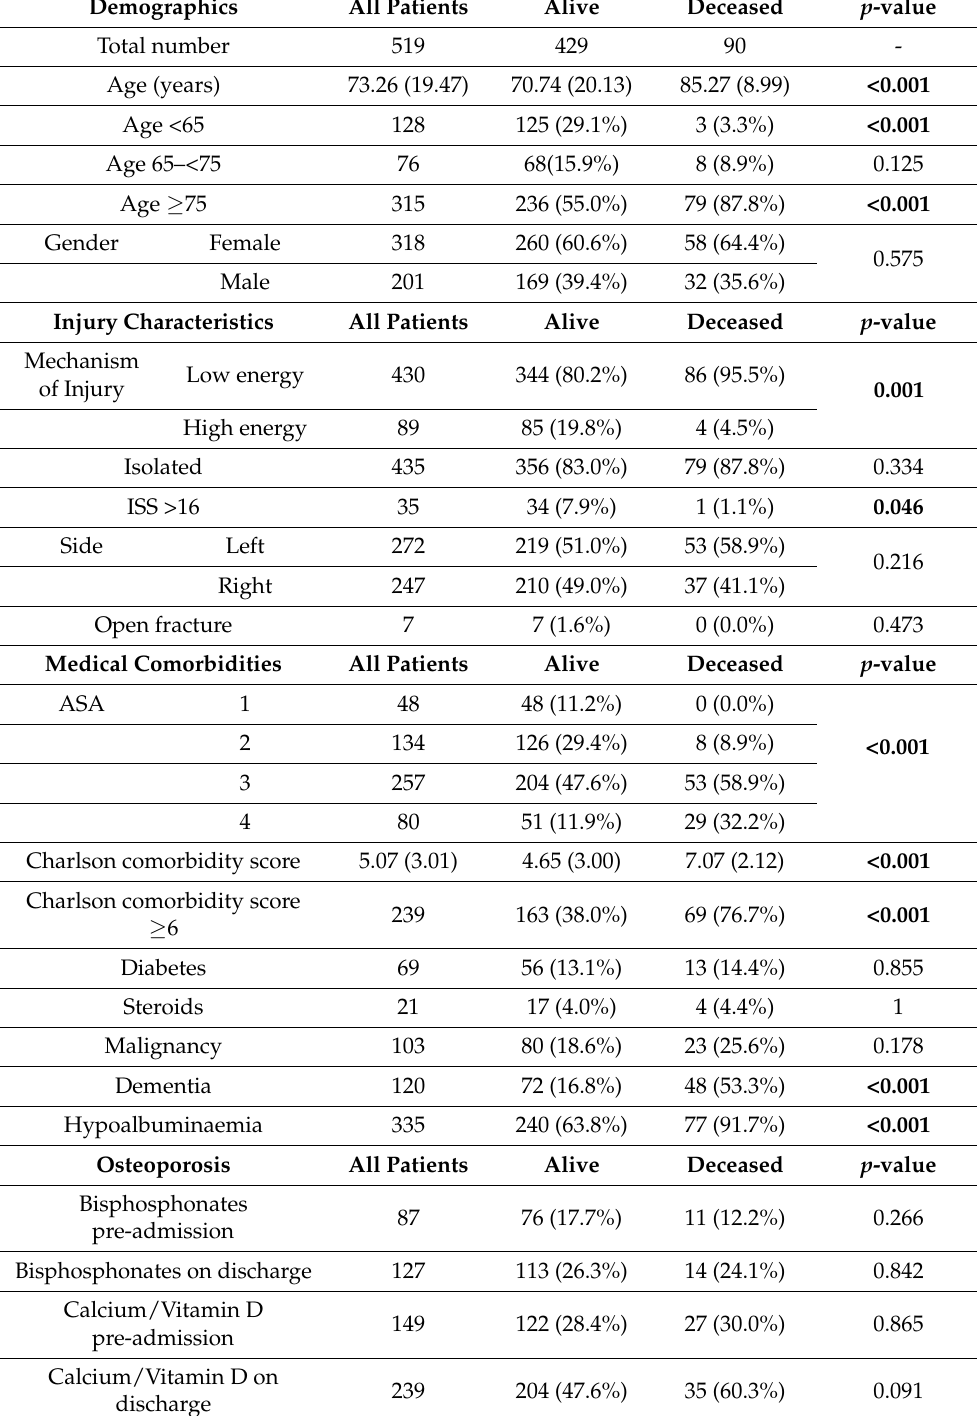
Table A1. The demographics/characteristics of patients having a subtrochanteric fracture treated with a long cephalomedullary nail, stratified according to one-year